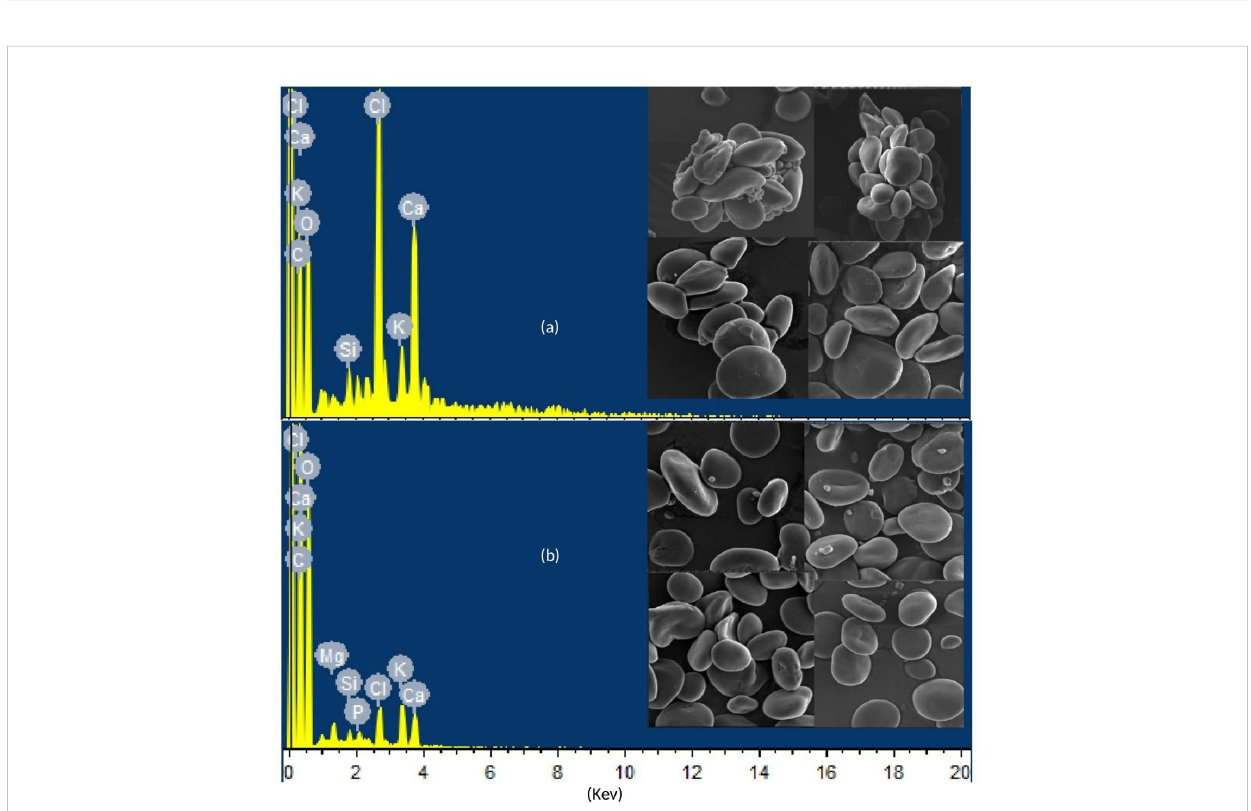
FIGURE 8 Scanning electron microscope (SEM) spectrographs and micrographs showing differential elemental distribution and starch granulation, respectively, in representative samples of wheat genotypes Gold-16 and Hemai-13, respectively, under (A) the control treatment and (B) combined drought and heat